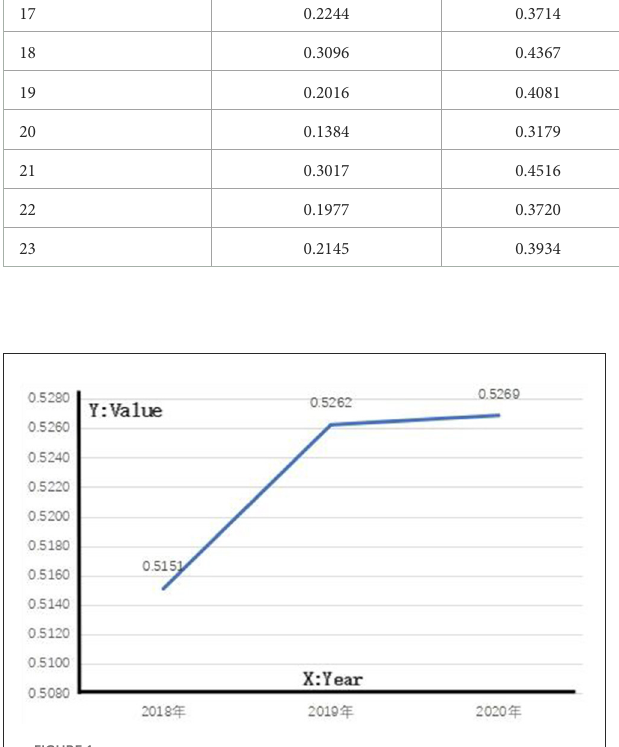
FIGURE1 Implementation effect of hierarchical diagnosis and treatment policies in